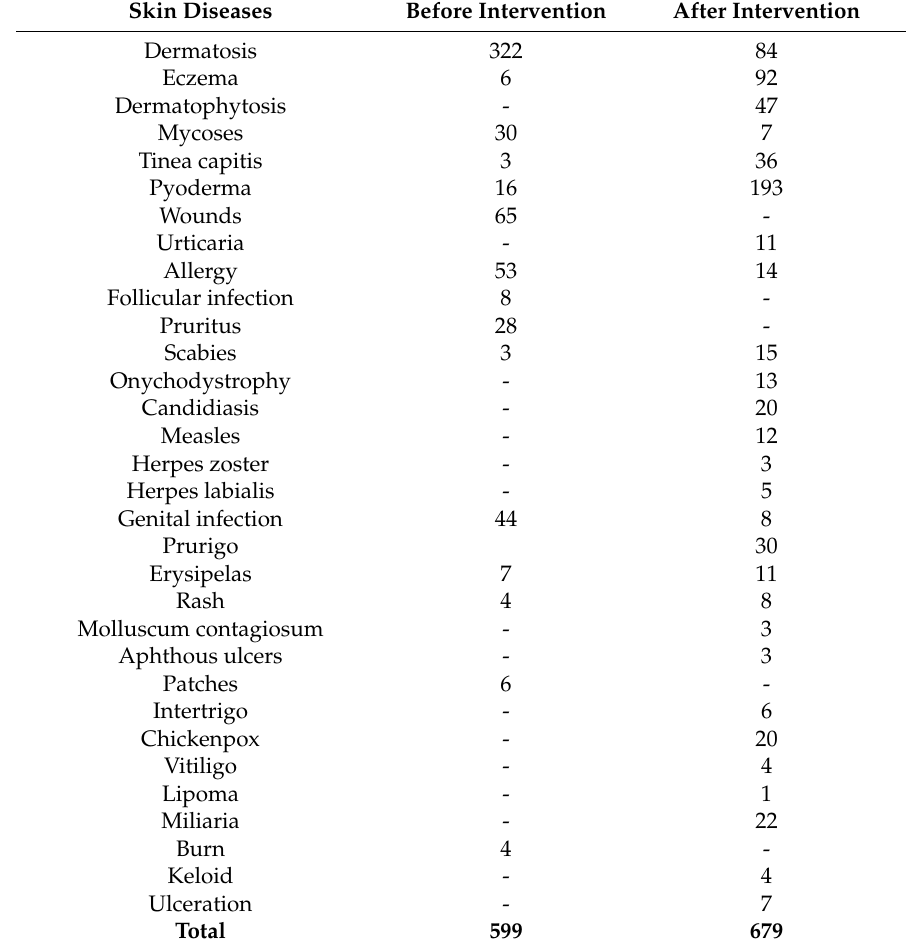
Table 2. Pattern of skin diseases observed in health centres before and after intervention: report on the six-month